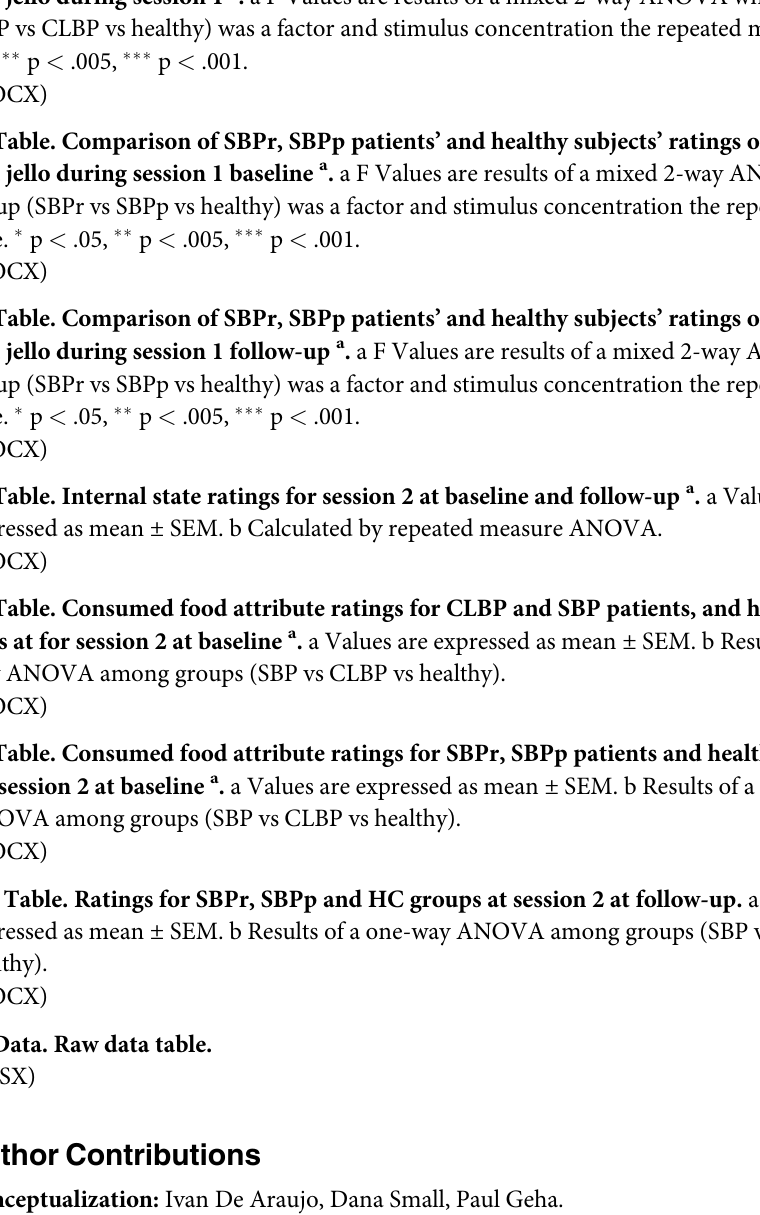
S3 Table. Internal state ratings for SBPr and SBPp patients, and for healthy subjects for session 1 at follow-up a . a Values are expressed as mean ± SEM. b Calculated by repeated mea- sure ANOVA. S4 Table. Comparison of SBP, CLBP patients’ and healthy subjects’ ratings of puddings and jello during session 1 a . a F Values are results of a mixed 2-way ANOVA where group (SBP vs CLBP vs healthy) was a factor and stimulus concentration the repeated measure. � p < .05, �� p < .005, ��� p < .001. S5 Table. Comparison of SBPr, SBPp patients’ and healthy subjects’ ratings of puddings and jello during session 1 baseline a . a F Values are results of a mixed 2-way ANOVA where group (SBPr vs SBPp vs healthy) was a factor and stimulus concentration the repeated mea- sure. � p < .05, �� p < .005, ��� p < .001. S6 Table. Comparison of SBPr, SBPp patients’ and healthy subjects’ ratings of puddings and jello during session 1 follow-up a . a F Values are results of a mixed 2-way ANOVA where group (SBPr vs SBPp vs healthy) was a factor and stimulus concentration the repeated mea- sure. � p < .05, �� p < .005, ��� p < .001. S7 Table. Internal state ratings for session 2 at baseline and follow-up a . a Values are expressed as mean ± SEM. b Calculated by repeated measure ANOVA. S8 Table. Consumed food attribute ratings for CLBP and SBP patients, and healthy sub- jects at for session 2 at baseline a . a Values are expressed as mean ± SEM. b Results of a one- way ANOVA among groups (SBP vs CLBP vs healthy). S9 Table. Consumed food attribute ratings for SBPr, SBPp patients and healthy subjects for session 2 at baseline a . a Values are expressed as mean ± SEM. b Results of a one-way ANOVA among groups (SBP vs CLBP vs healthy). S10 Table. Ratings for SBPr, SBPp and HC groups at session 2 at follow-up. a Values are expressed as mean ± SEM. b Results of a one-way ANOVA among groups (SBP vs CLBP vs